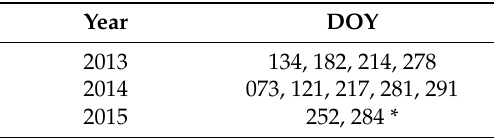
Table 1. Day of Years (DOYs) of remote-sensing images used in this